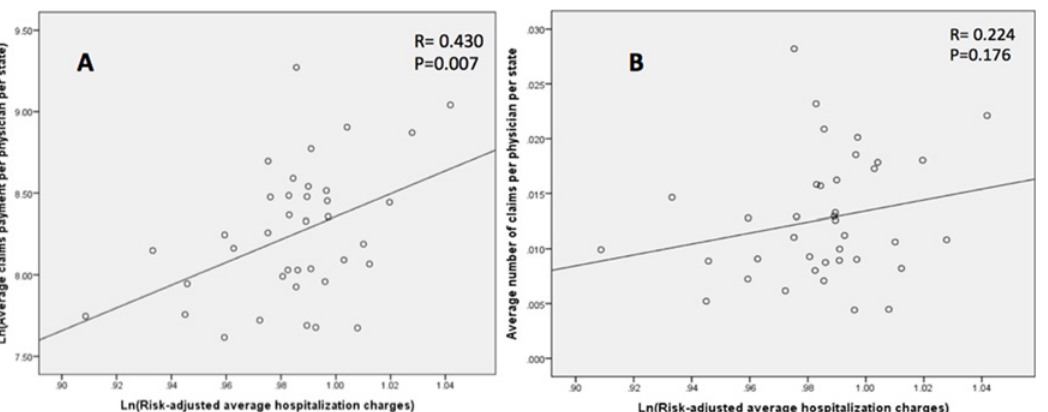
Fig 5. Scatter plot demonstrating the correlation of the ln-transformed average state-level hospitalization charges for cranial neurosurgical procedures and average size (ln-transformed) (A) and number (B) of paid claims per physician per